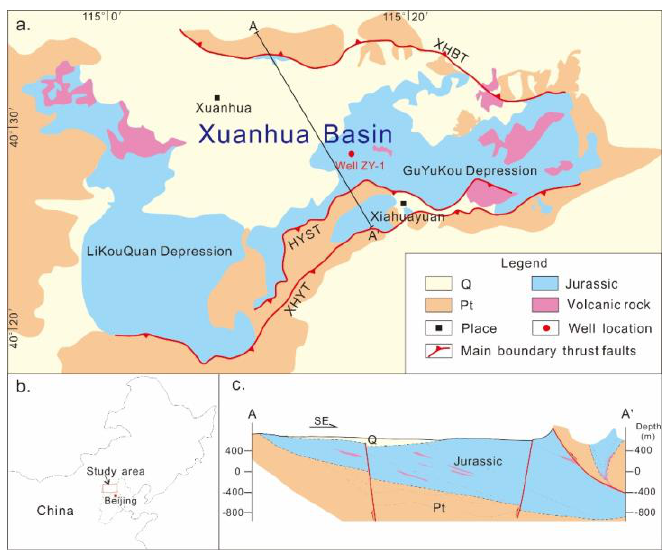
Figure 1. Geological sketch, location, and cross-section of the Xuanhua Basin. ( a ) Geological sketch with sampling well location. ( b ) Study area location. ( c ) Cross-section A–A 0 (modified after [37]). Q: Quaternary, Pt: Proterozoic, XHBT: Xuanhuabei thrust fault, HYST: Huangyangshan thrust fault, XHYT: Xiahuayuan thrust